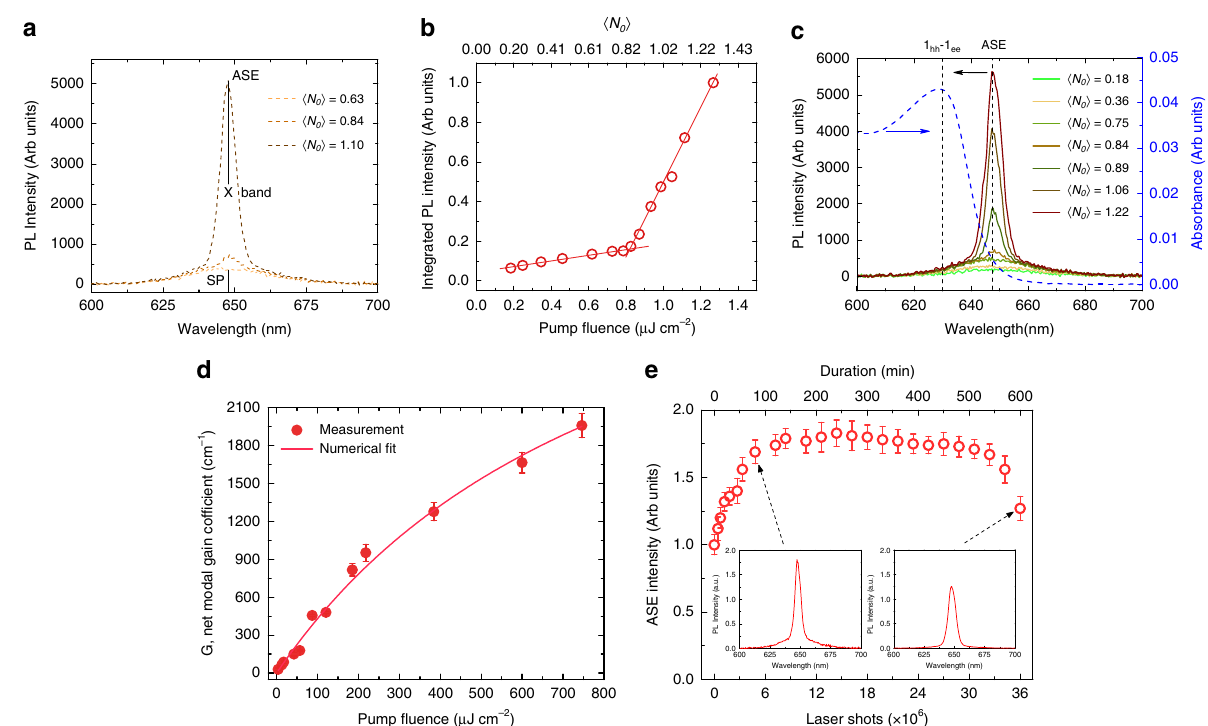
Fig. 3 ASE, VSL, and optical gain stability characterizations of the CQWs having four monolayers of shell. a Pump-dependent ASE spectra at 〈 N o 〉 = 0.63, 0.84, and 1.10. The position of spontaneous emission (SP), ASE and X-band are marked by solid black line. b Integrated PL intensity of ASE spectra as a function of the pump fl uence and the corresponding average number of excitons per NPL ( 〈 N o 〉 ). c Spectral analysis of ASE along with absorbance (dashed blue line) of the lowest excitonic energy state with respect to the 〈 N o 〉 . The position of 1 hh – 1 e excitonic transition and ASE peak are marked by dark dashed lines. d Pump-dependent net peak modal gain coef fi cient (symbols) at the ASE peak position ( λ ASE = 647 nm). The solid line is the numerical fi tting to the experimental data, indicating a saturation fl uence at ~920 μ J cm − 2 . The highest G reaches 1960 ± 100 cm − 1 at 746 μ J cm − 2 pump fl uence. Error bars in this fi gure are a result of uncertainty of the fi tting parameter in the variable stripe length measurement presented in Supplementary Fig. 7 as exemplary cases. e Pump-dependent ASE intensity as a function of the pump laser shot at 〈 N o 〉 = 1.36. Error bars in this fi gure comes from the fl uctuations in the ASE intensity between different measurements. The light ampli fi cation is highly stable in these engineered CQWs even for 9.5 h of continuous